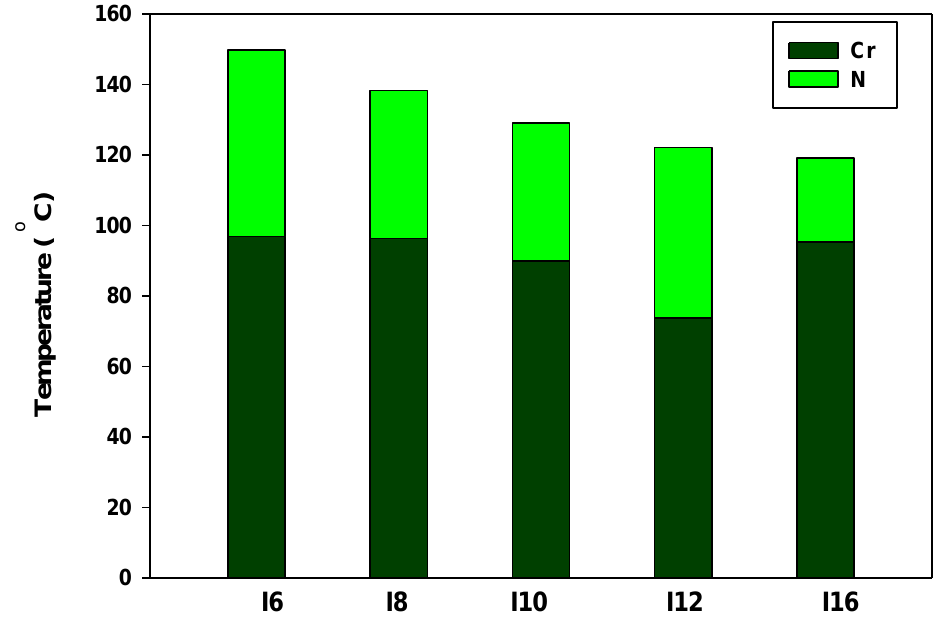
Figure 4. Impact of terminal chain length ( n ) on the mesomorphic behavior of the present homologous I n series.